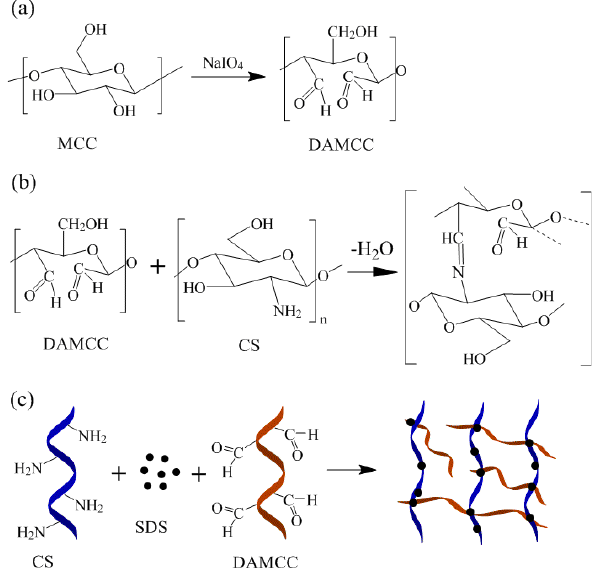
Figure 1: (a) MCC oxidized to DAMCC by NaOI 4 ; (b) Schiff base reac-